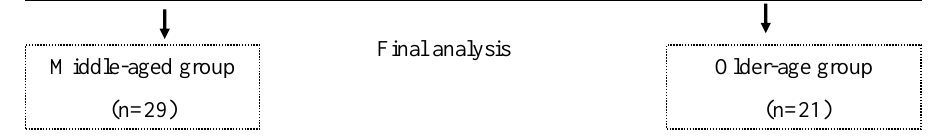
12 were excluded from the study because of lack of data, and MPT was not measured at 3 month after cardiac surgery.